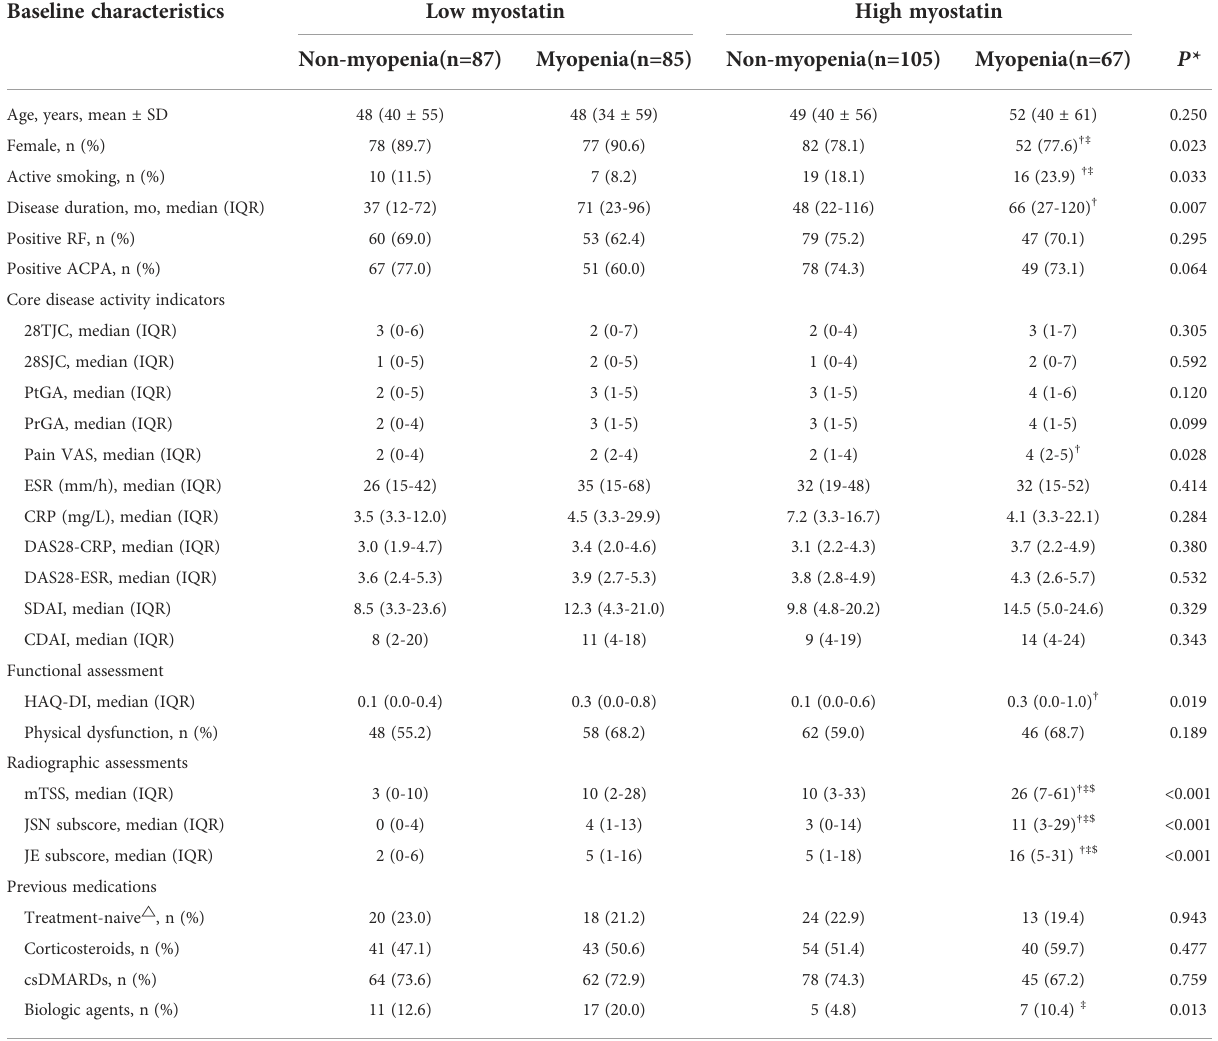
TABLE 3 Comparisons of baseline characteristics among four RA subgroups by baseline serum myostatin and myopenia. Baseline